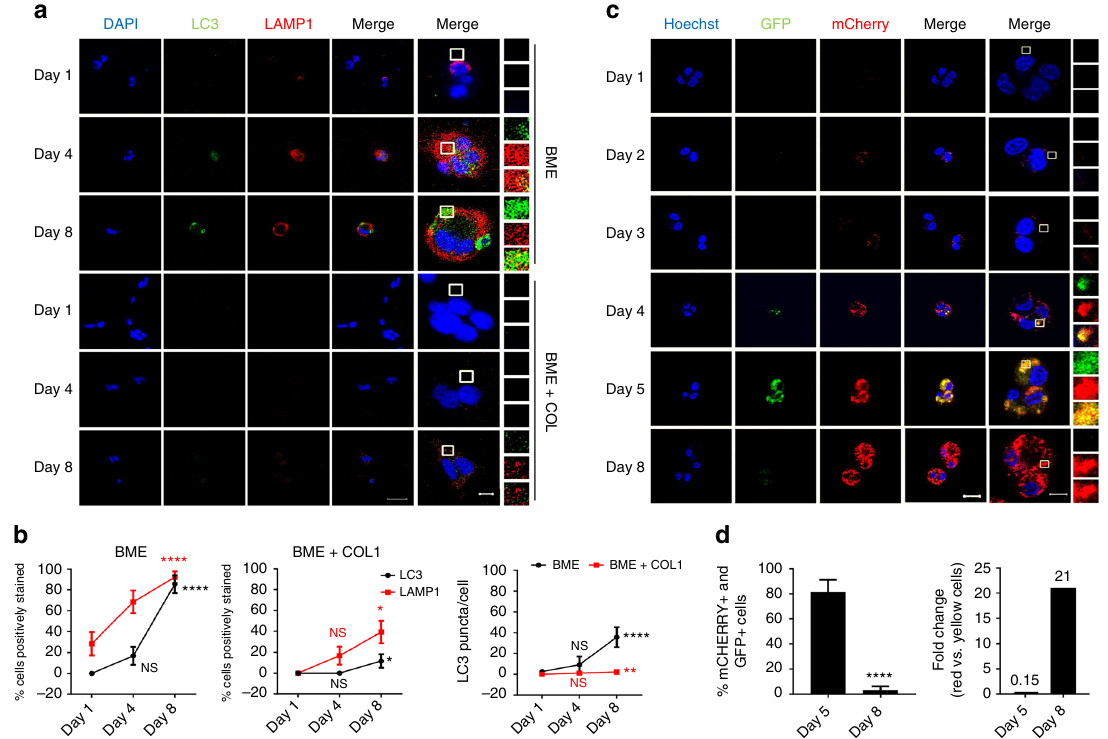
Fig. 1 D2.0R cells activate autophagy upon entering a dormant state. Representative images are shown for a Immuno fl uorescent staining of lysosomal (LAMP1, red) and autophagic (LC3, green) markers of D2.0 R cells in BME (upper panels) and BME + COL1 (lower panels) with b Quanti fi cation of the percentage of cells exhibiting LC3 positive puncta and LAMP1 staining out of the total number of cells analysed (mean ± s.e.m, n = 30 – 42 cells. Comparisons are relative to Day 1 by Kruskal – Wallis, Dunn ’ s post test. * P ≤ 0.05; **** P ≤ 0.0001) and the average number of LC3 puncta per cell (Comparisons by Kruskal – Wallis, Dunn ’ s post test. ** P ≤ 0.01 and **** P ≤ 0.0001). c D2.0 R cells transfected with the mCherry-GFP-LC3 reporter show activation and completion of the autophagic cycle (red fl uorescence only) when plated in BME matrices for 8 days. d The graphs represent the percentage of cells with double-positive puncta (mCherry + and GFP + ) (autophagosomes) out of the total number of cells analysed (left graph) (mean ± s.e.m, n = 35 – 39 cells). Comparisons by Kruskal – Wallis, Dunn ’ s post test. **** P ≤ 0.0001) and the rate of conversion from cells exhibiting yellow puncta to red-only puncta expressed as fold change (right graph). Scale bars are 50 and 10 μ m for a and 20 and 10 μ m for